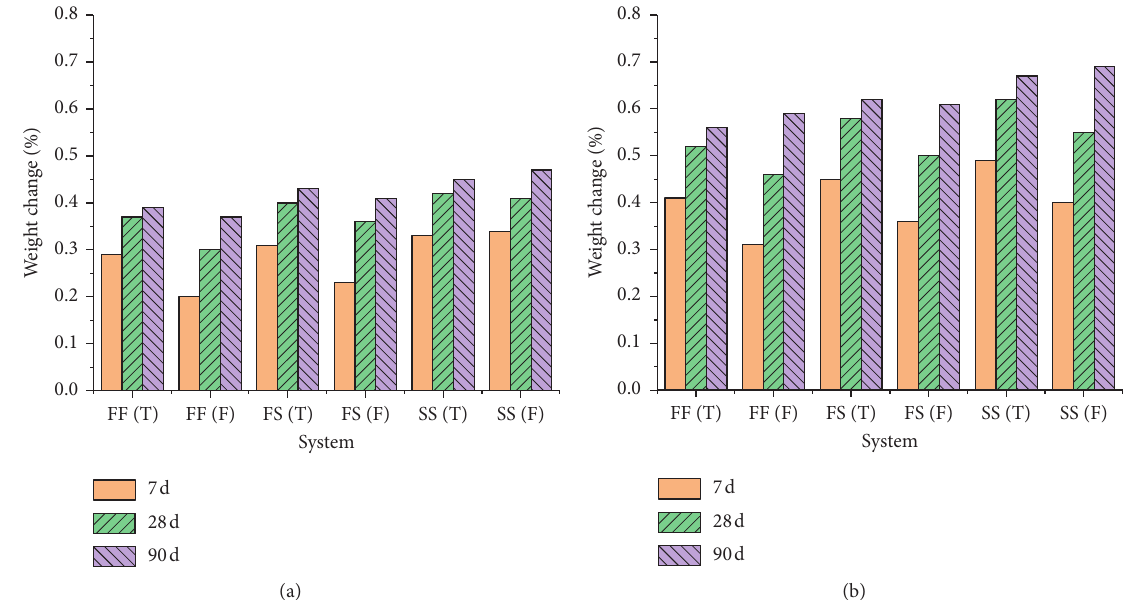
Figure 4: Weight changes of different cement content systems. (a) 5% cement content systems. (b) 8% cement content systems.